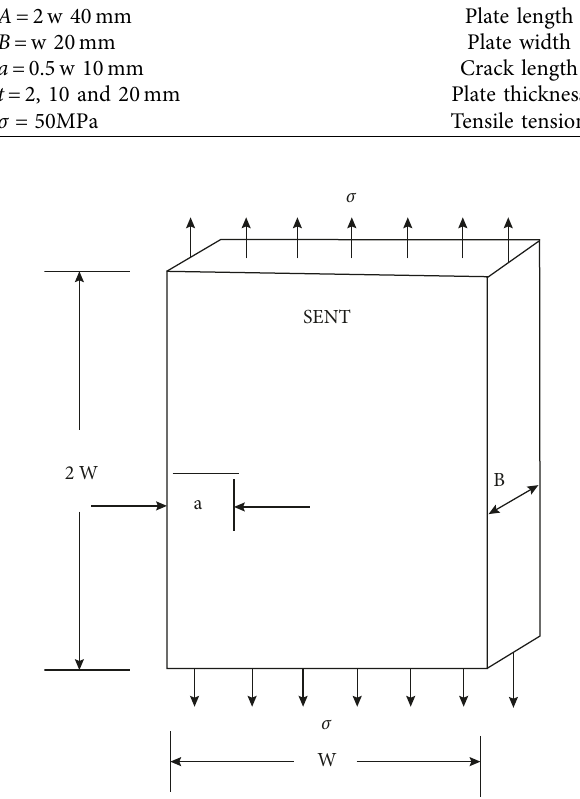
Figure 13: Loading kind and the situation of crack in three-di- mensional object